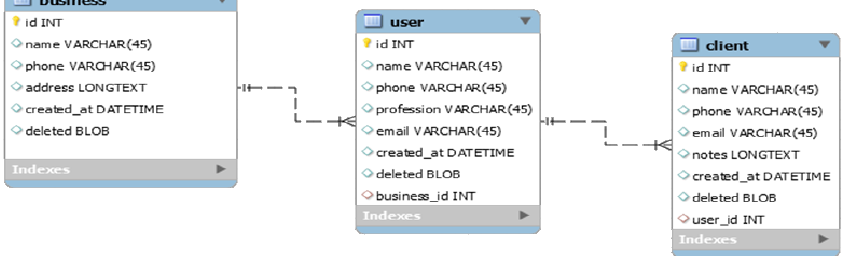
Figure 1. Relational database structure.